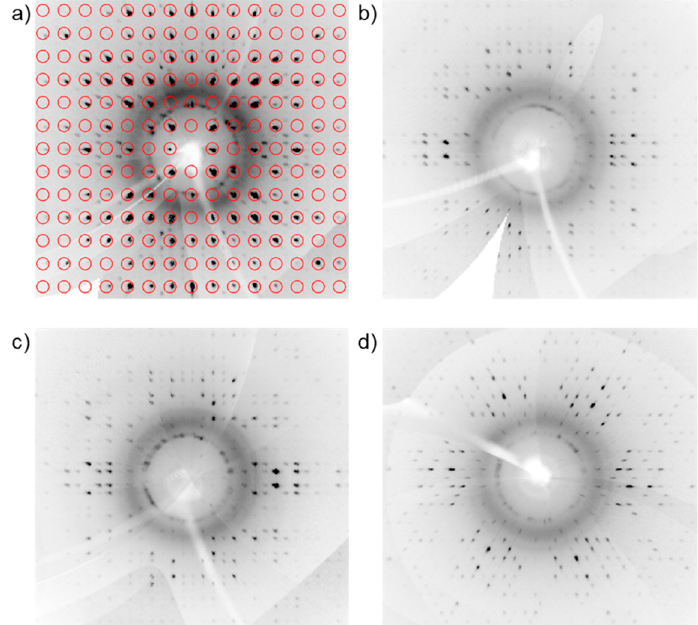
Figure 3. Synthesized precession images of a crystal of (Bi 8 )Tl[AlCl 4 ] 3 at 170 K. Additional reflections in the h 0 l plane do not correspond to the reflection pattern of the room temperature unit cell ( a ). The 0.5 kl ( b ), h 0.5 l ( c ) and hk 0.33 ( d ) planes show extensive, symmetric reflection patterns indicating the 2a × 2b × 3c supercell.